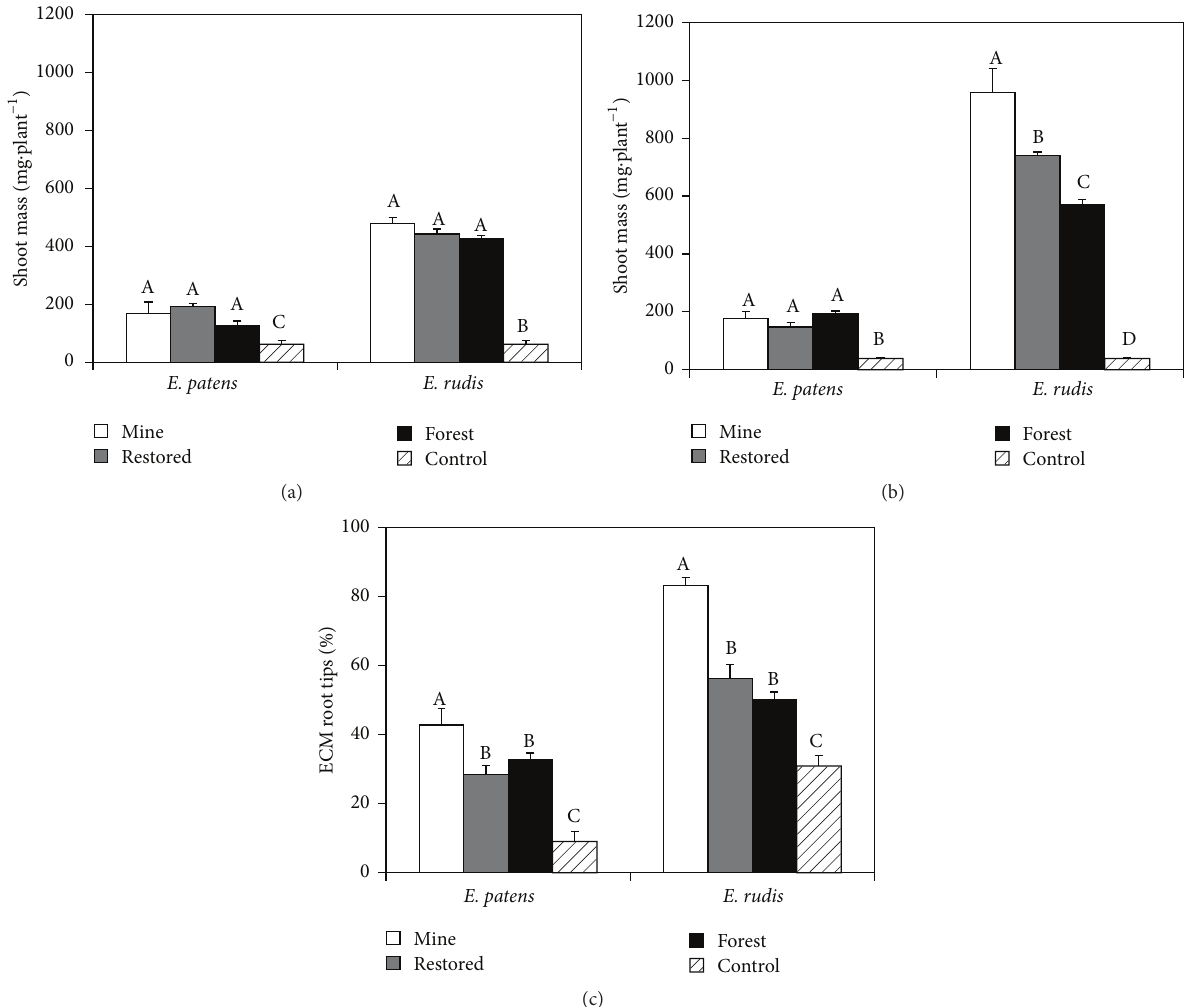
Figure 1: Effect of mine, restored, or forest site Pisolithus ecotype on the shoot biomass (a), root biomass (b), and fine root ectomycorrhizal colonization (c) in Eucalyptus plants in the pot trial. Vertical bars indicate the standard error of the mean. For each plant species, mean biomass or root colonization values with the same letter do not differ significantly at 𝑝 < 0.05